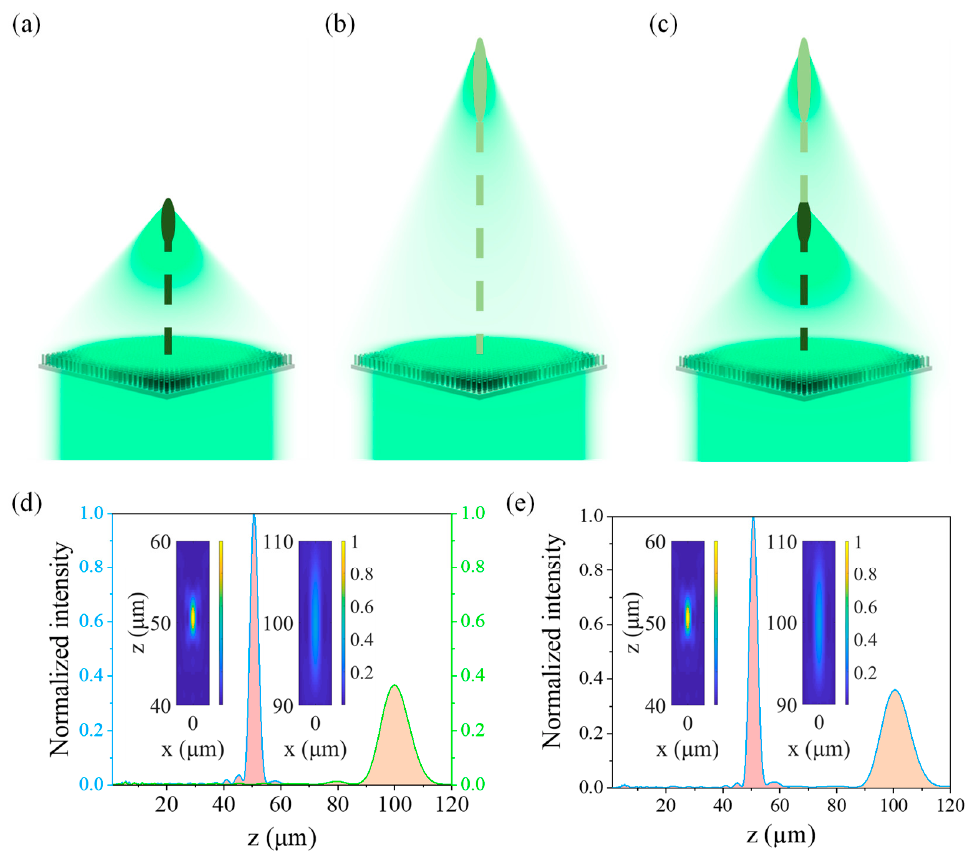
Figure 4. Multifocal metalenses for different polarized light. ( a ) RCP light. ( b ) LCP light. ( c ) LP light. Intensity distributions of the focal field for a multifocal metalens along the z axis and the vertical plane for incident of ( c ) RCP light (blue curve), ( d ) LCP light (green curve), and ( e ) LP light.